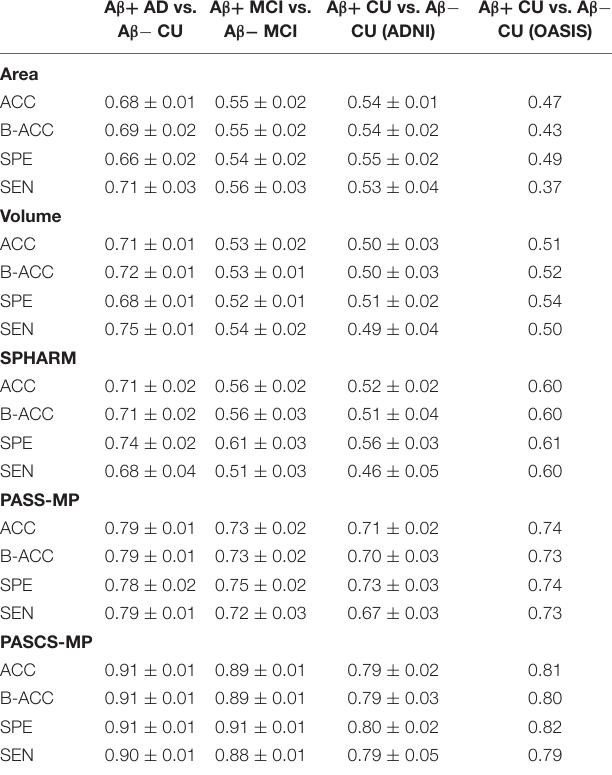
TABLE 2 | Classification results for four